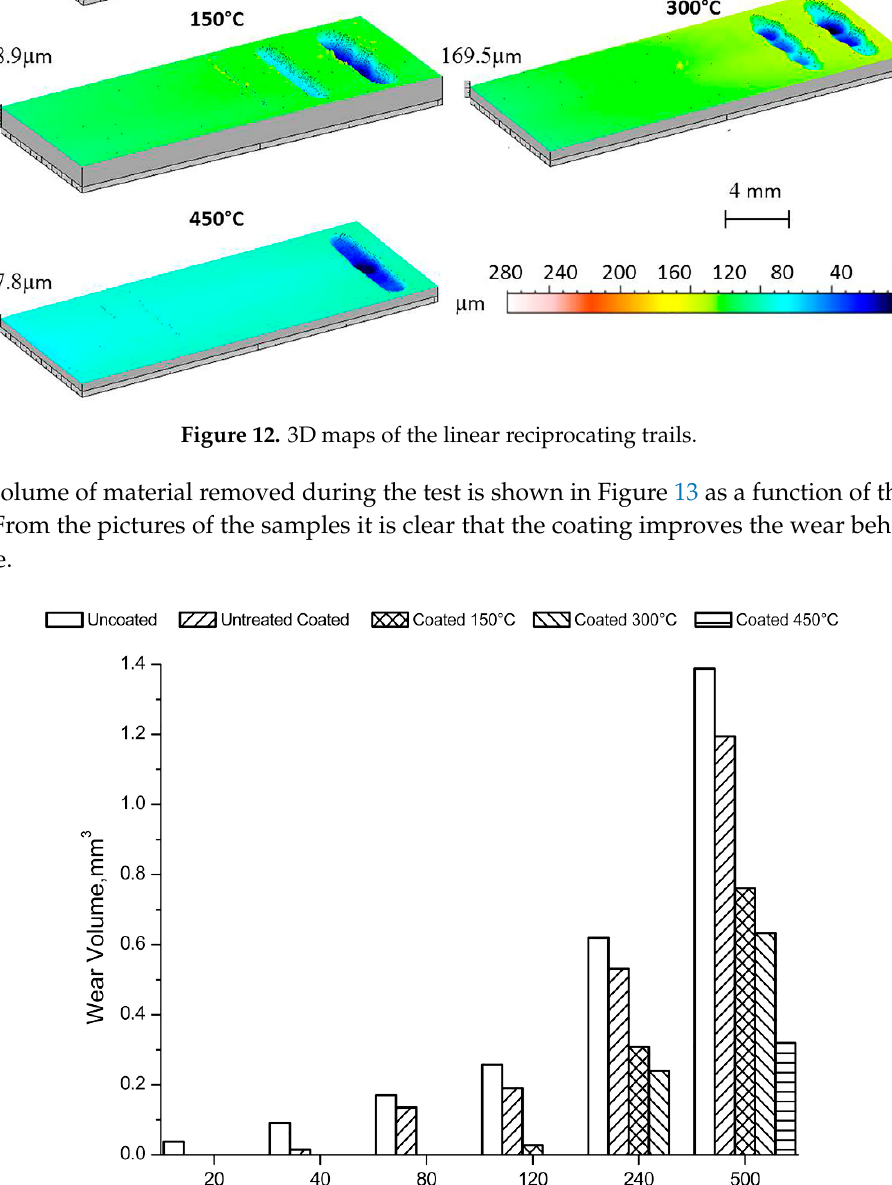
Figure 13. Wear volume removed during the test, as function of distance.